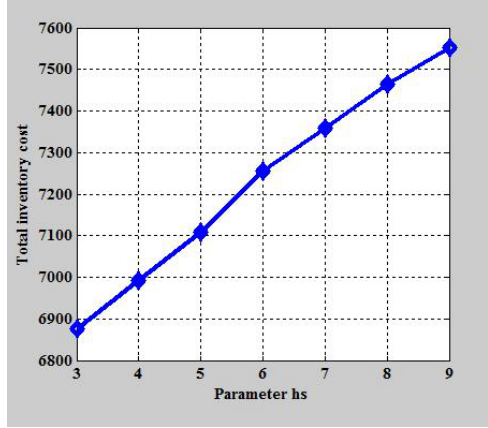
Fig 4: Sensitivity: parameter h s v/s TC Fig 5: Sensitivity: parameter c p v/s